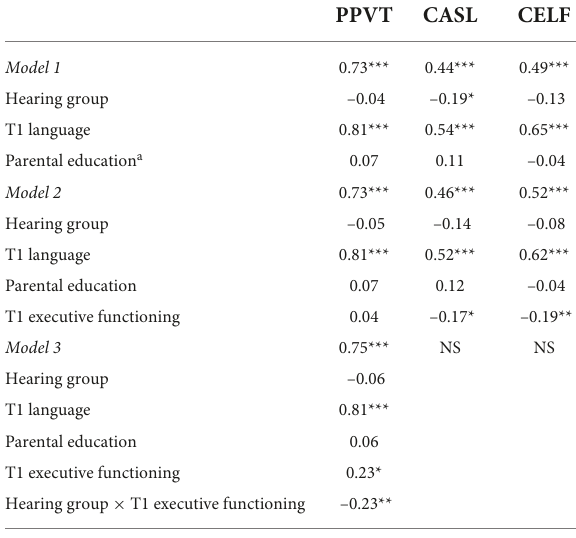
TABLE 4 Hierarchical linear regressions predicting T2 language